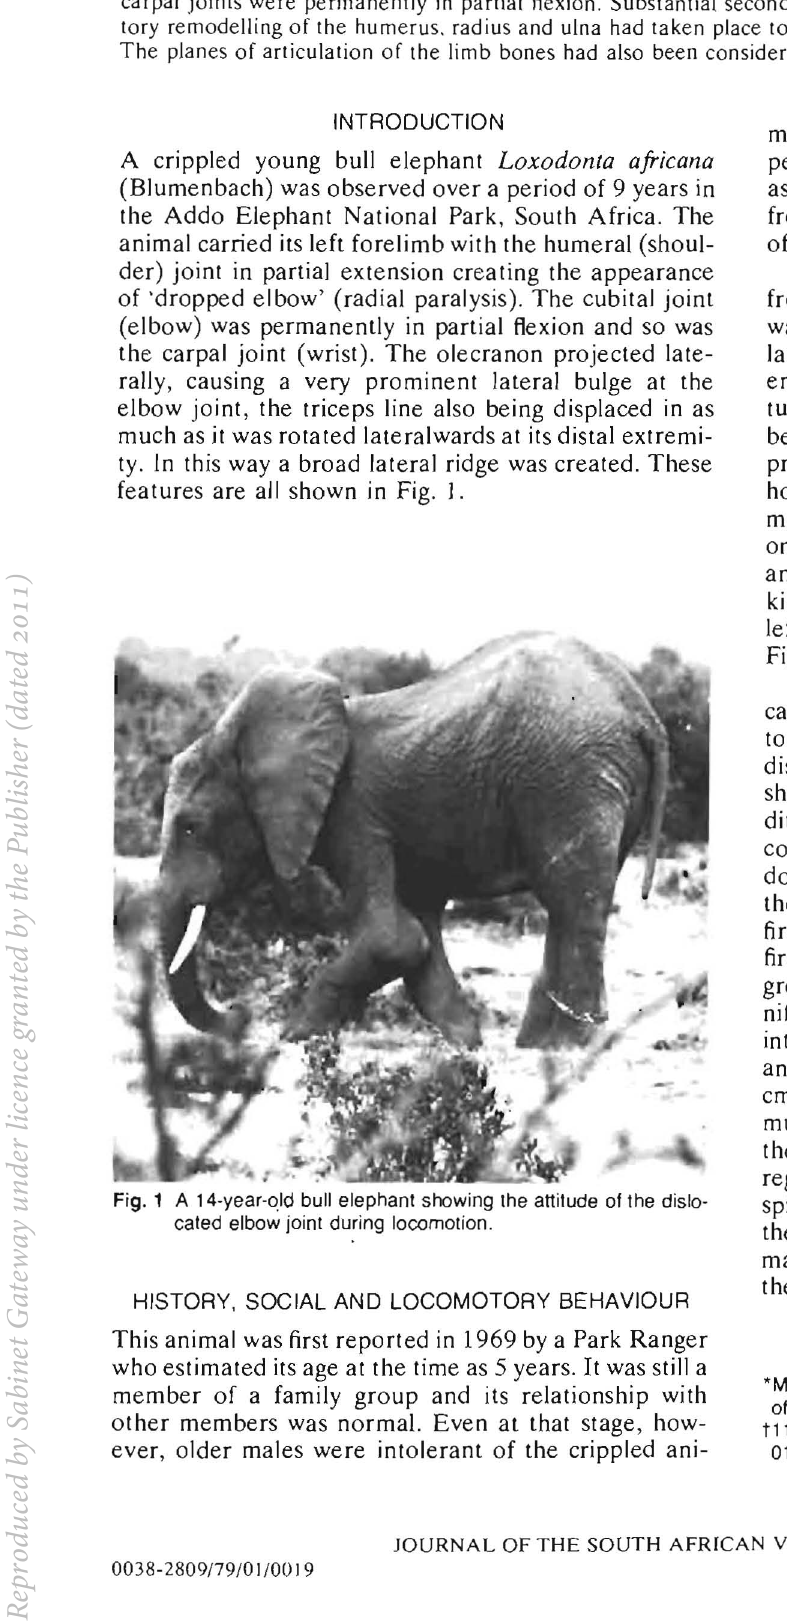
HISTORY, SOCIAL AND LOCOMOTORY